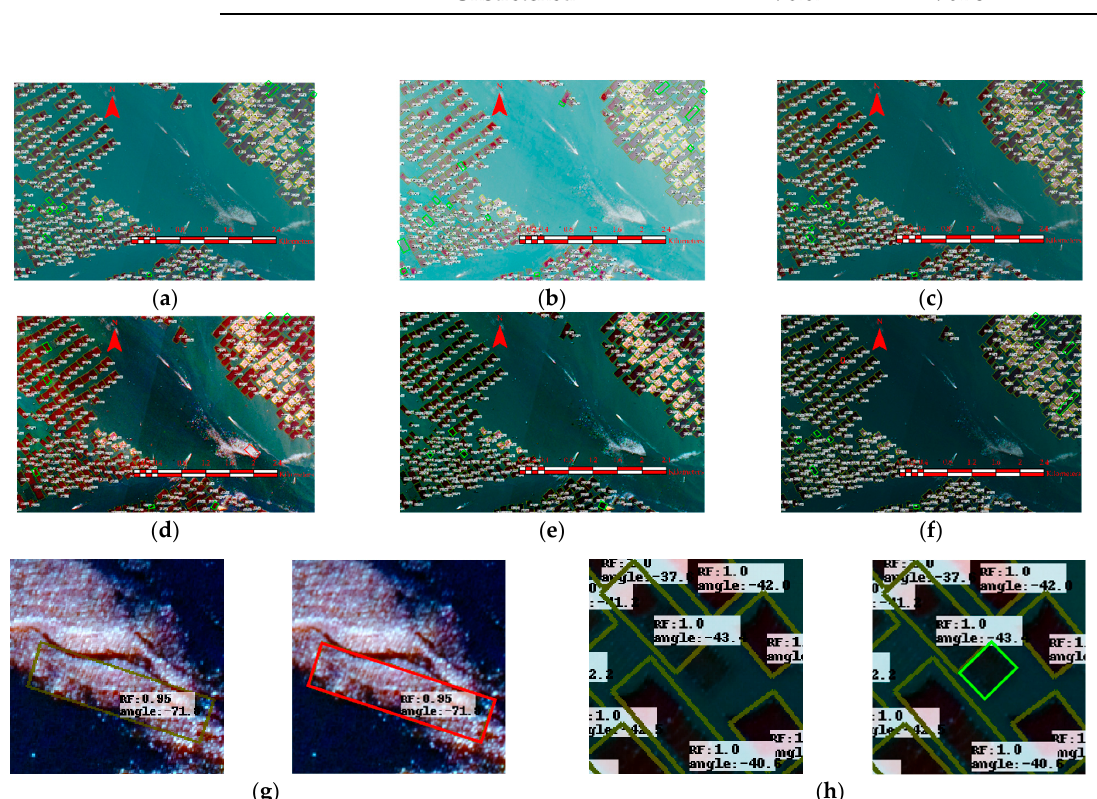
Figure 10. Resulting images of R 3 Det extraction aquaculture zone under different stretching conditions. The red rectangles represent misidentified aquaculture zones, and the green rectangles represent aquaculture zones not included by the bounding box. ( a ) Square root stretching: 13 green rectangles. ( b ) Logarithmic stretching: 14 green rectangles. ( c ) Gaussian stretching: 10 green rectangles and one red rectangle. ( d ) Equalization stretching: seven green rectangles and one red rectangle. ( e ) Piecewise linear stretching (ours): six green rectangles. ( f ) Unstretched: 11 green rectangles and one red rectangle. ( g ) Images of misidentified result ( left ) and manually annotated ( right ). ( h ) Images of aquaculture zones not fully included by the bounding box ( left ) and manually annotated ( right ).